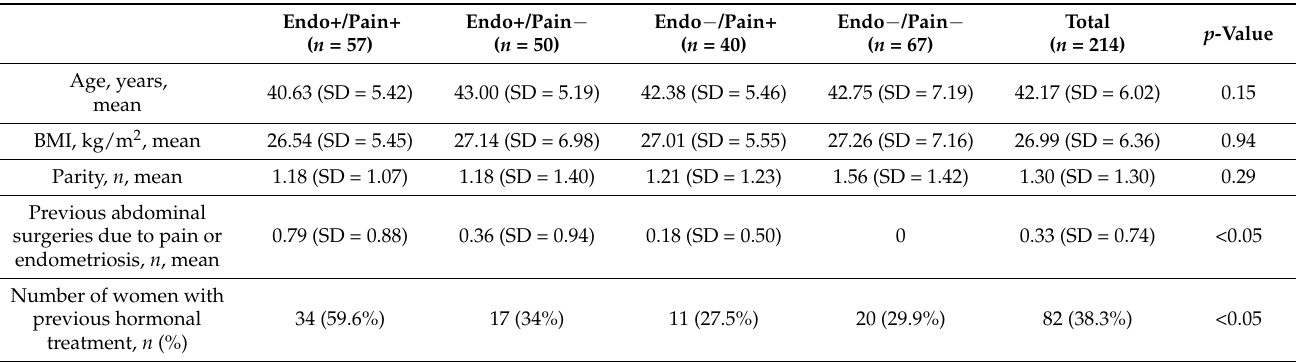
Table 1. Patient characteristics.